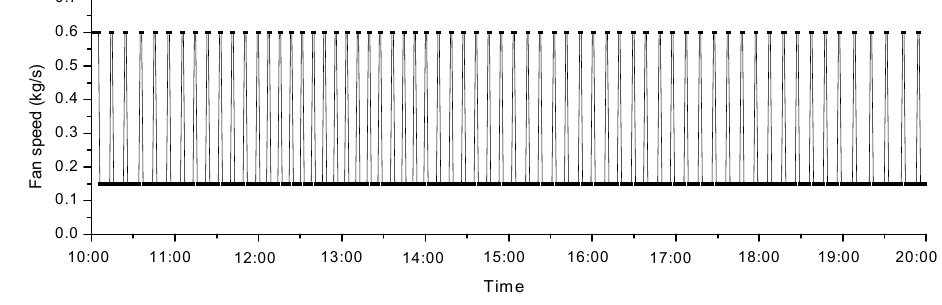
Figure 3. Fan speed fluctuation in a typical day.